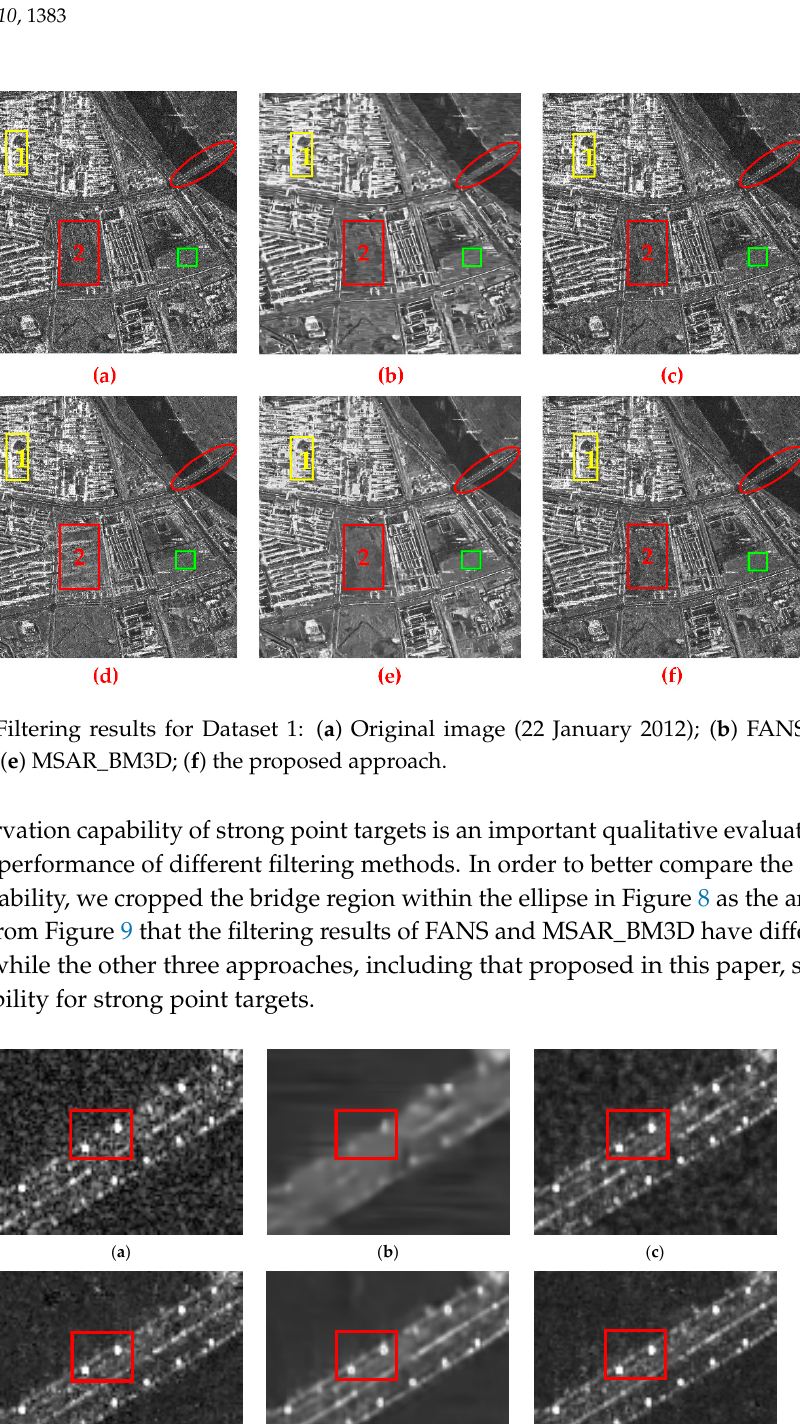
Figure 9. Preservation of strong target points for Dataset 1. ( a ) Original image (22 January 2012); ( b ) FANS; ( c ) QF; ( d ) CDMF; ( e ) MSAR_BM3D; ( f ) the proposed approach.